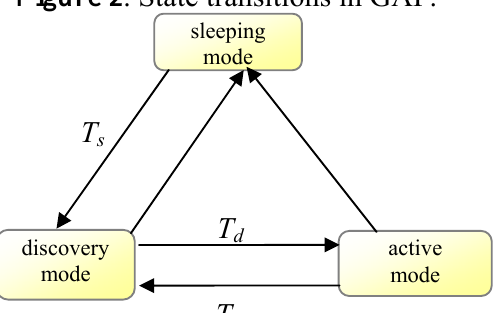
Figure 2 . State transitions in